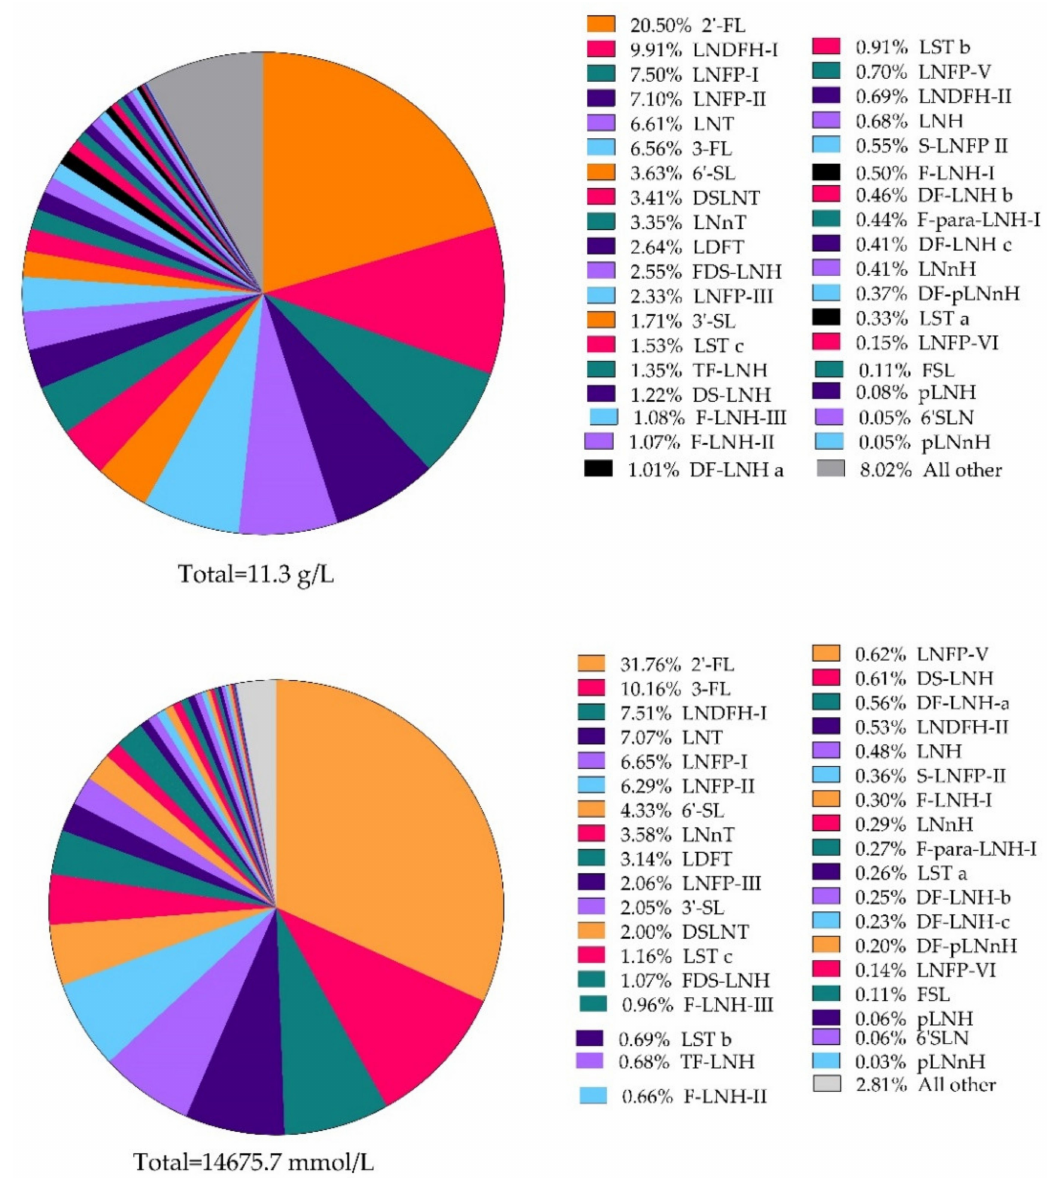
Figure 4. Putative composition of the HMO fraction based on g/L and